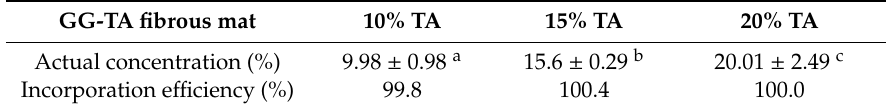
Table 1. Incorporation efficiency of GG fibrous mats loaded with TA.